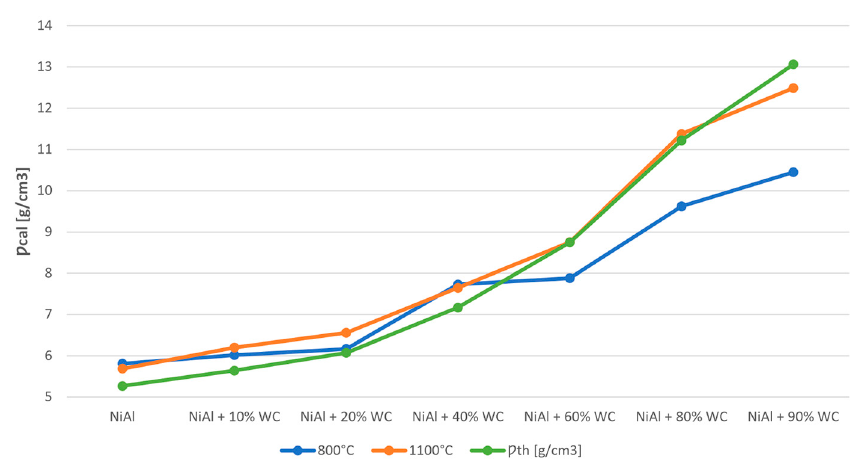
Figure 12. Calculated density and theoretical density of NiAl-xWC composites sintered at 800 °C and 1100 °C.